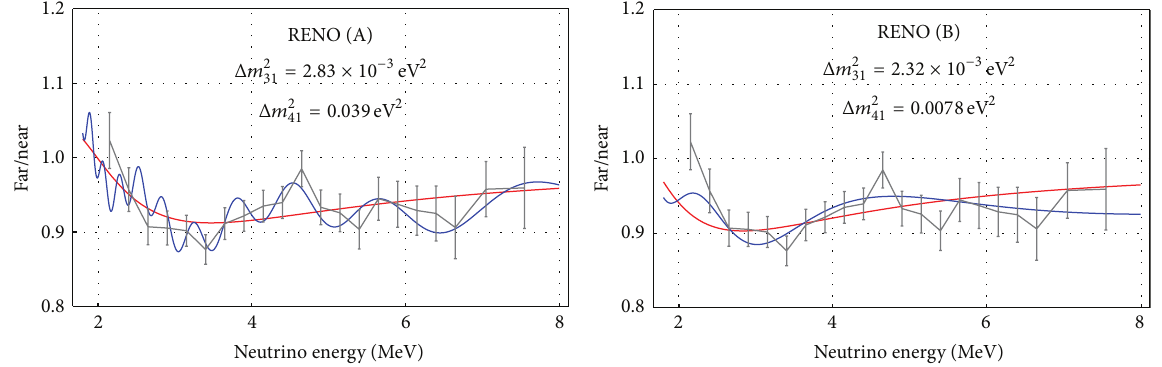
Figure 3: The data and error bars are the reproduction of updated RENO for an extended period until October 2012. The red fits are drawn with sin 2 2𝜃 14 = 0 for Δ𝑚 2 31 = 2.83 × 10 −3 eV 2 and for Δ𝑚 2 31 = 2.32 × 10 −3 eV 2 obtained from the analysis in Figure 4. For each case, the blue fits are overlaid which are the superposition with Δ𝑚 2 41 = 0.039 eV 2 oscillation of amplitude sin 2 2𝜃 14 = 0.050 , and the superposition with = 0.0078 eV 2 oscillation of amplitude sin 2 2𝜃 = 0.054 , respectively, obtained from the analysis in Figure Δ𝑚 2 14 41